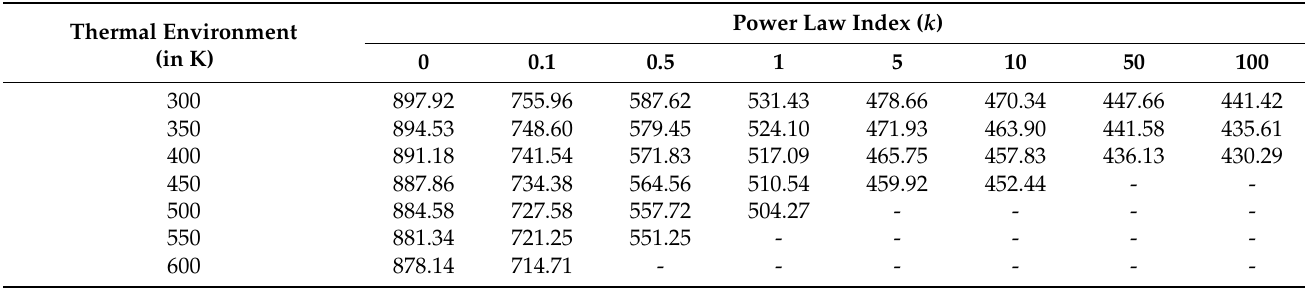
Table 5. Effect of a uniform thermal field on critical buckling temperatures (in K) of an aluminum/silicon carbide FGM shell for different material composition in re-entry vehicle nose